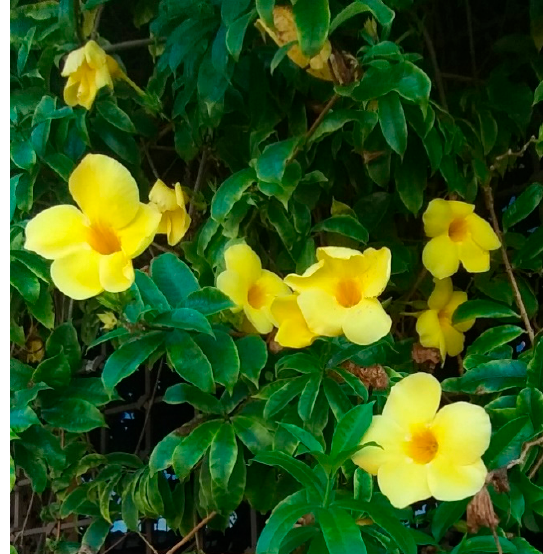
Figure 1. Allamanda cathartica .